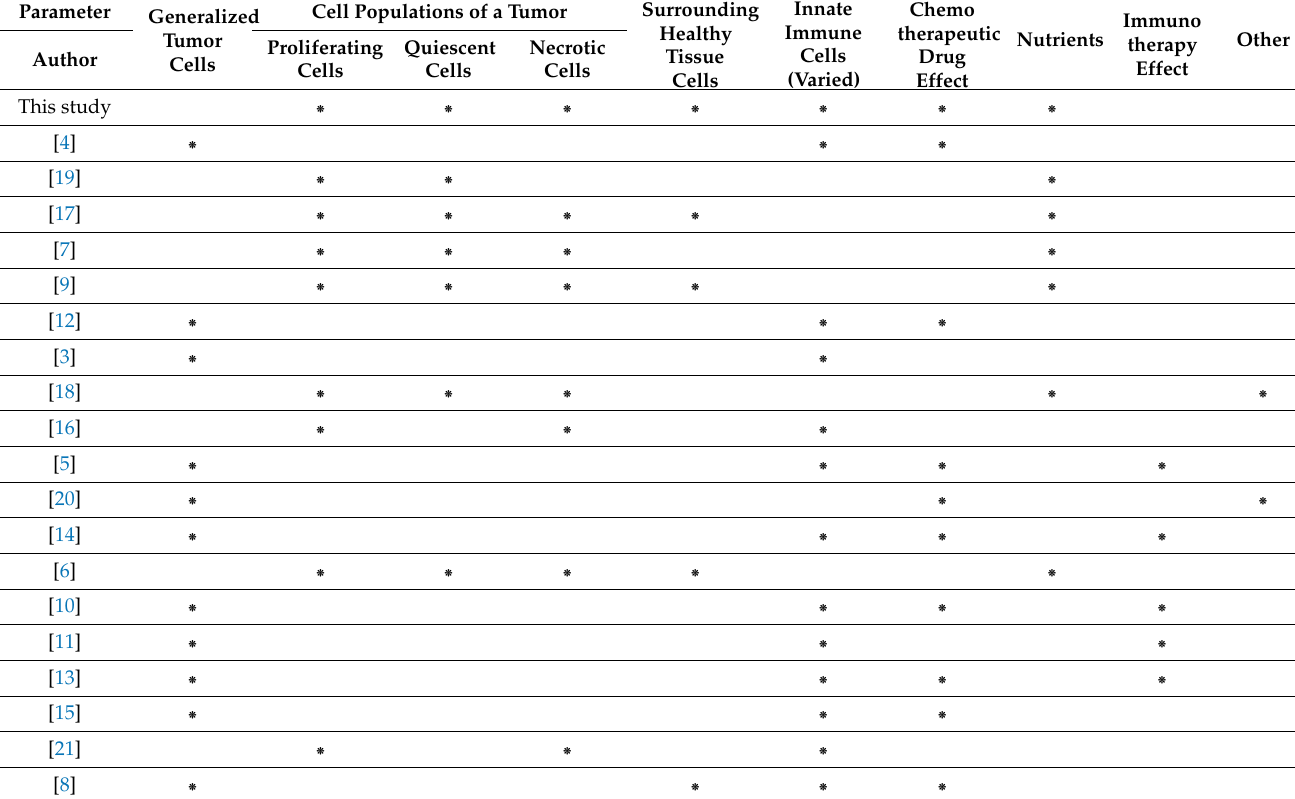
⁕ Parameter of an avascular tumor mathematical model considered in a research paper.